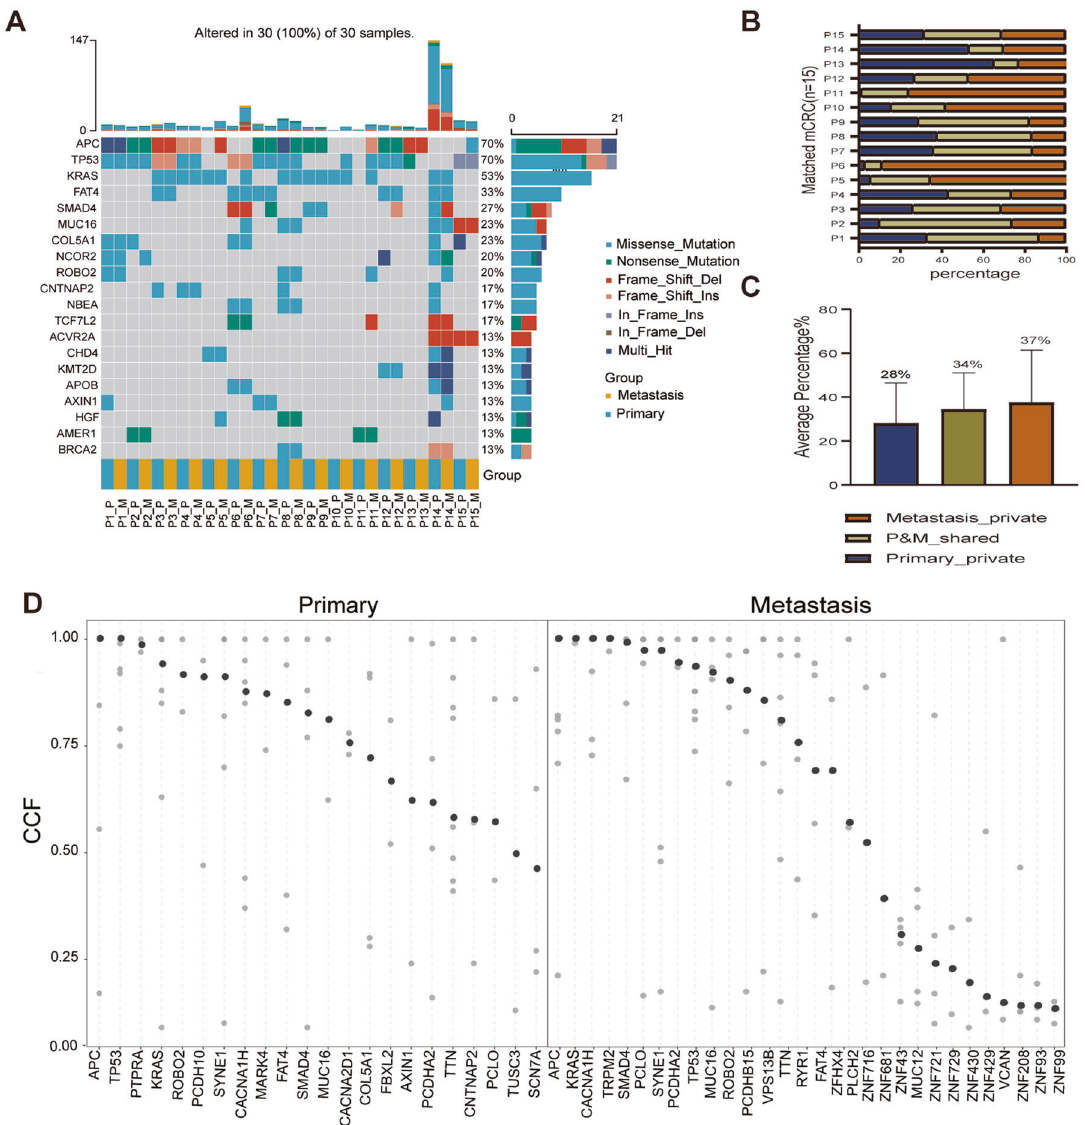
Fig. 1 The mutational landscape and proportion and timing order of mutational genes during CLM evolution. A Mutations with high mutational frequencies in CRC primary tumors and metastases. B The proportion of shared, primary-private and metastasis-private mutations in CRC. C The distributions of CCF value of recurrent somatic events in CRC primary and metastases. CCF assessment was performed as described in “ Materials and methods. ” CLM colorectal liver metastasis, CRC colorectal cancer, CCF cancer cell